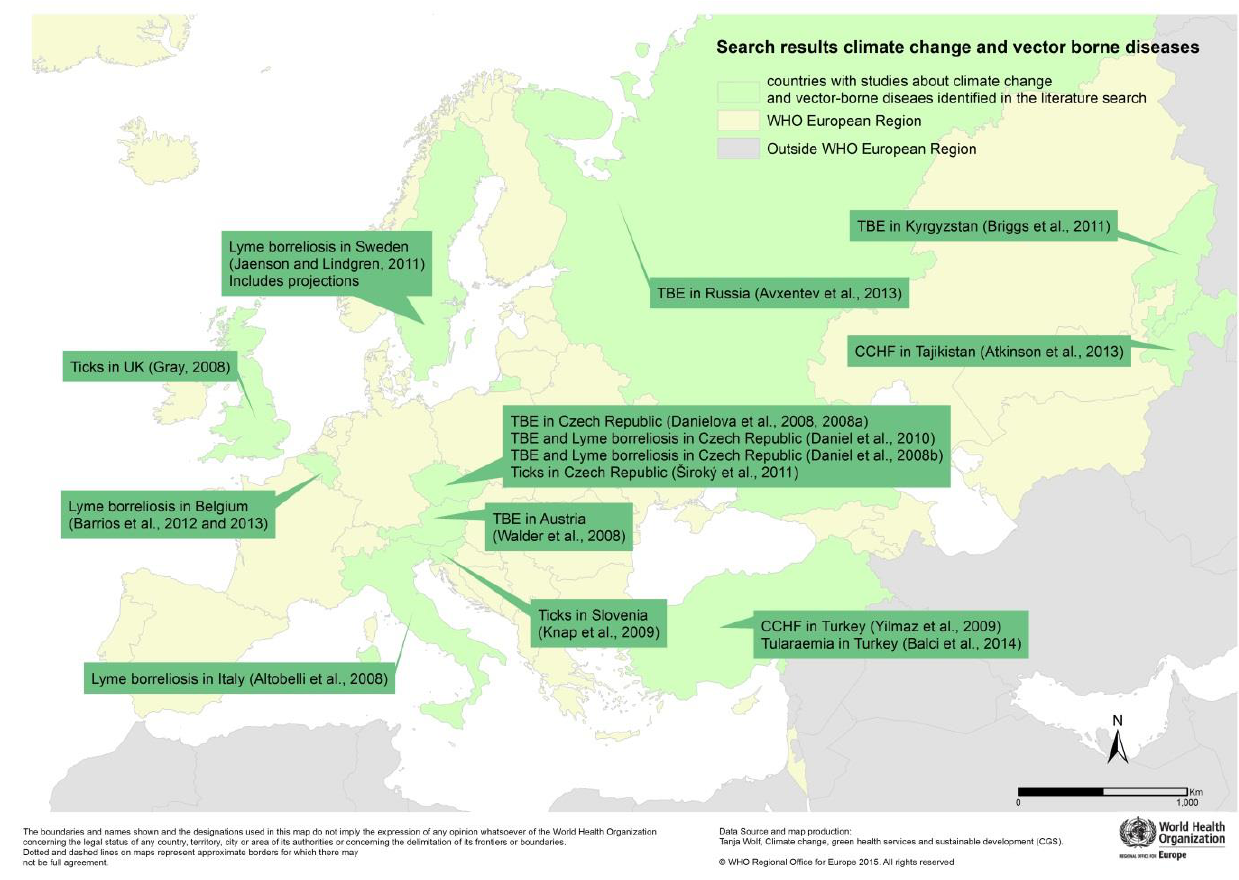
Figure 2. Search results (17) of literature about climate change and tick-borne infectious diseases